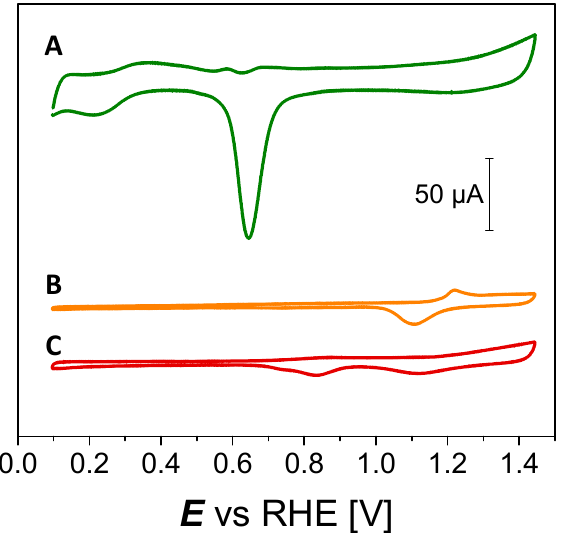
Figure 3. Tenth stable cycle voltammograms (CVs) recorded at 5.0 mV s − 1 and 293 K in a N 2 -purged 0.10 mol L − 1 NaOH aqueous electrolyte of ( A ) Pd/C, ( B ) Au/C and ( C ) Pd 3 Au 7 /C materials.